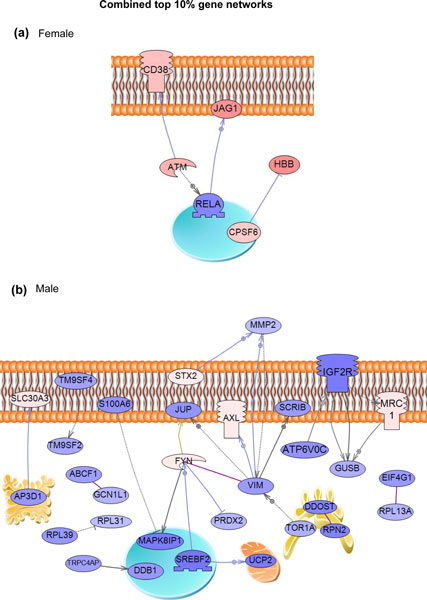
Direct connection gene sub-networks for the top 10% interconnected genes from each module of
the separate networks for female and male obtained by global literature analysis. (a)
Female; (b) male. Directly connected genes only are shown according to their location in
the cell (on the membrane, in the Golgi apparatus, nucleus, or cytoplasm or outside the cell). Node
shapes: oval and circle, protein; diamond, ligand; circle/oval on tripod platform, transcription
factor; ice cream cone, receptor; crescent, kinase or protein kinase; irregular polygon,
phosphatase. Color code: red, up-regulated genes; blue, down-regulated genes. Arrows with a plus
sign indicate positive regulation/activation; arrows with a minus sign indicate negative
regulation/inhibition; grey arrows represent regulation; lilac arrows represent expression; purple
arrows represent binding; green arrows represent promoter binding; yellow arrows represent protein
modification.